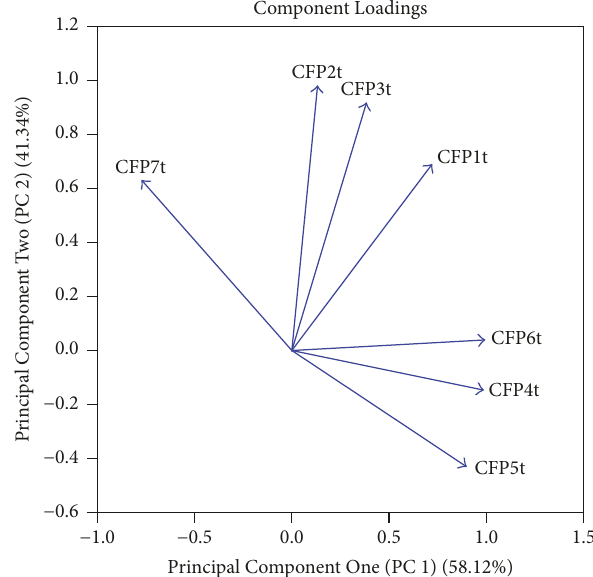
Figure 6: The plot illustrates the component loadings CFP1 to CFP7 for the 500 RR intervals of 31 traffic noise exposure subjects. The CFP values are deduced by using the MTM spectra throughout. The properties of the MTM spectra are as follows: sampling frequency 1Hz, DPSS of 3, FFT length of 256, and Thomson’s nonlinear combination at “adaptive.” CFP1 and CFP3 are the most influential components when assessed by